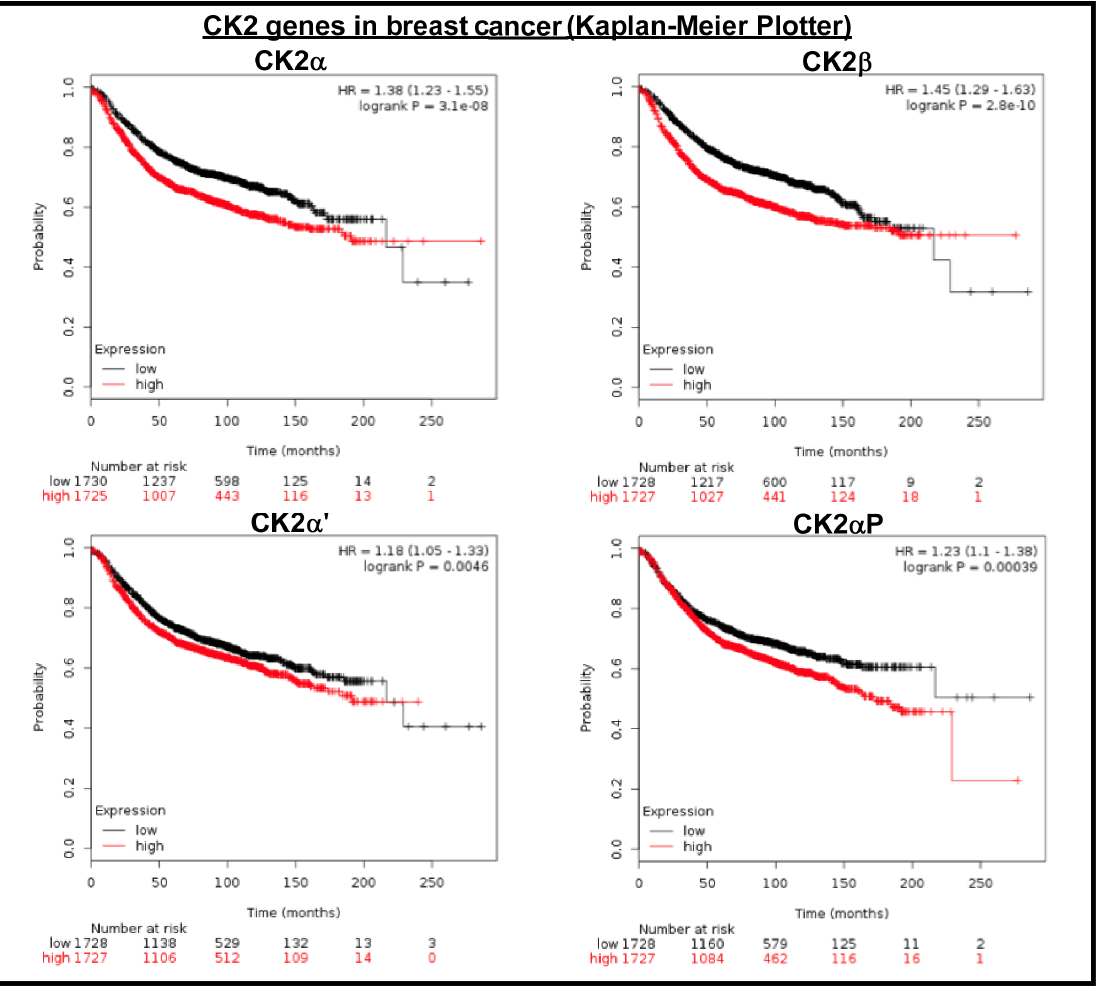
Fig. 5. CK2 genes in breast cancer (Kaplan-Meier Plotter). Kaplan-Meier plots showing overall survival in lung adenocarcinoma. In red: patients with expression above the median and in black, patients with expressions below the median. CK2 a , p 5 3.110 2 8 ; CK2 a P, p 5 3.9 10 2 4 ; CK2 a ’, p 5 4.6 10 2 3 ; CK2 b